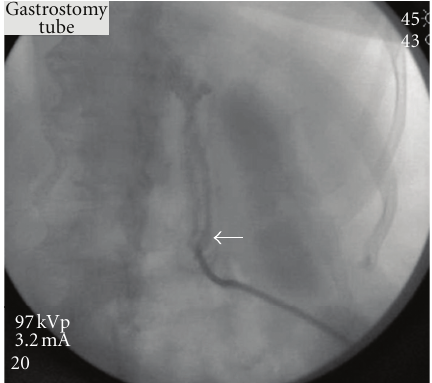
Figure 3: In RAO projection, a hemostat compressed the soft tissue against the insu ffl ated stomach (white arrow) excluding other viscera from the path. The nasogastric tube (black arrow) used for insu ffl ations lies above.